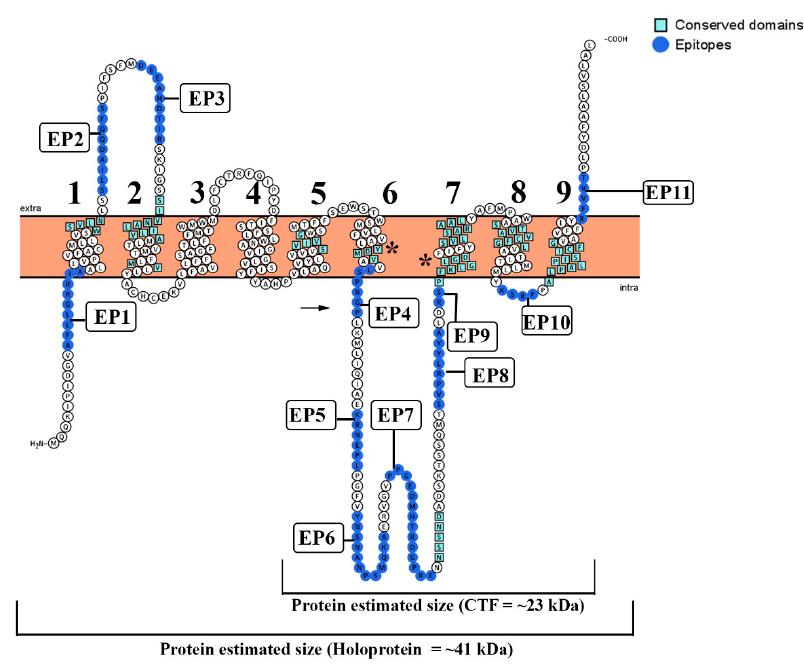
Figure 2. Modeling of T. cruzi PS as a multi-pass transmembrane protein. The model is based on the